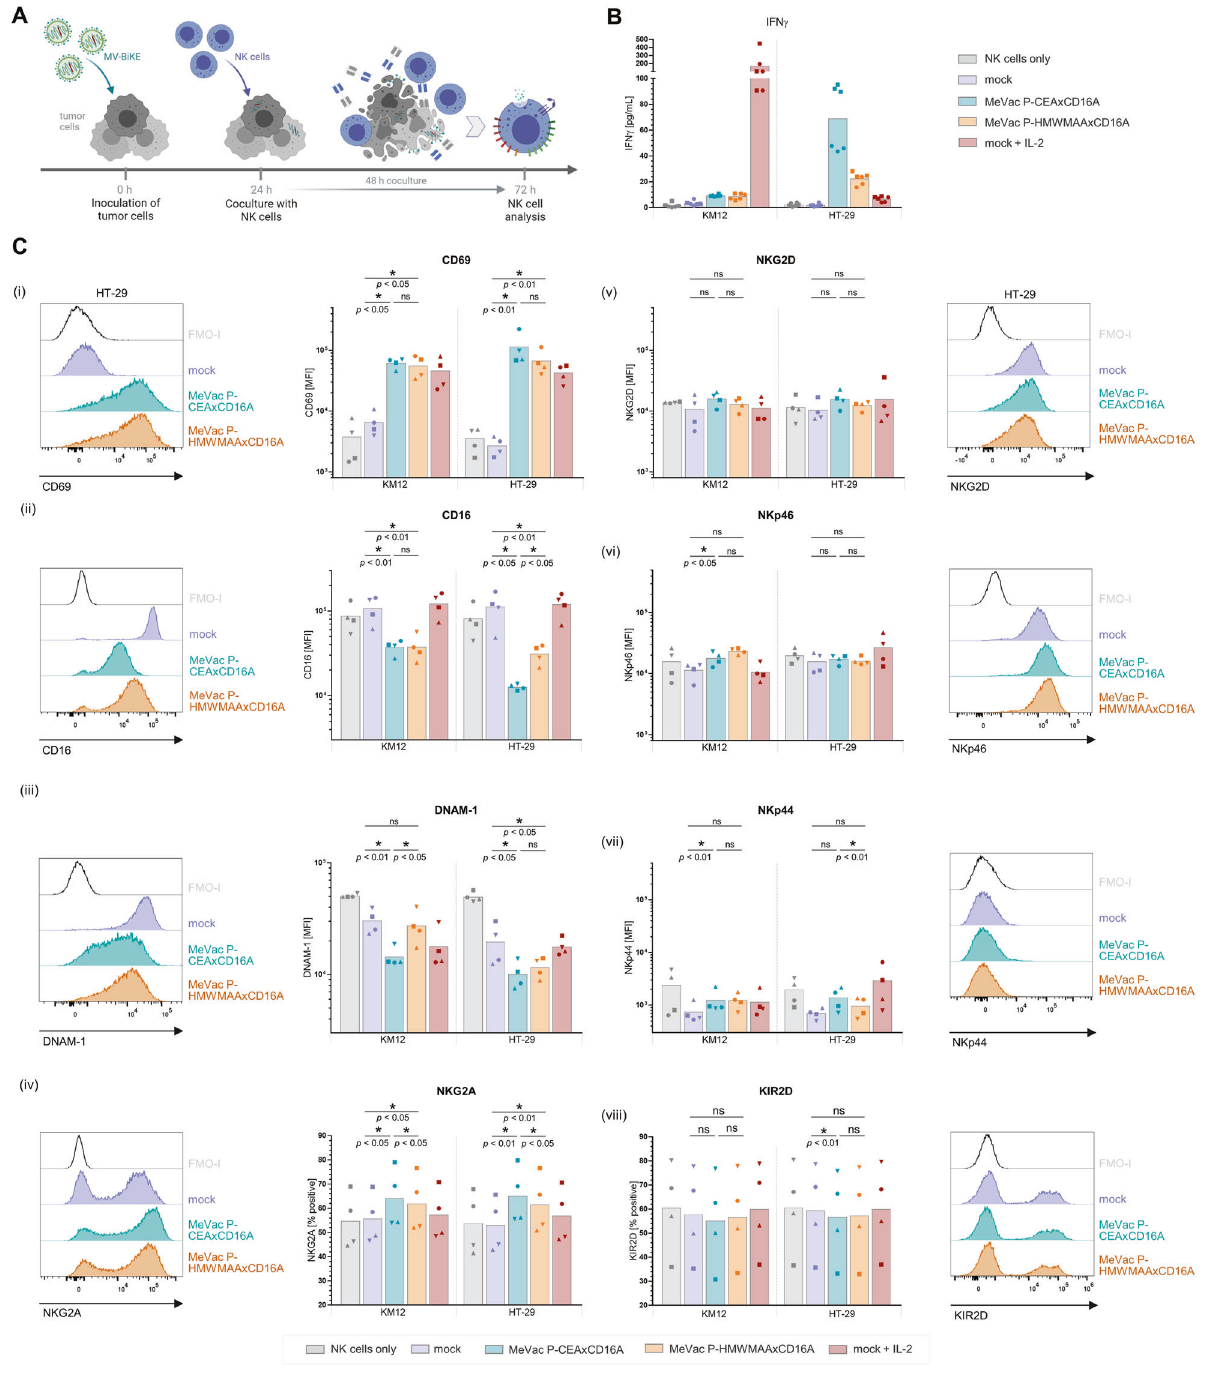
Fig. 4 NK cell characterization in response to MV or MV-BiKE therapy. NK cell surface markers and IFN γ release were analyzed after coculture with infected colorectal cancer cells. MV-BiKE infections were compared to NK cell only controls, mock or IL-2 stimulation. A Schematic outline of the experiment. B IFN γ concentrations in coculture supernatants were quanti fi ed by ELISA. Results are shown for KM12 and HT-29 tumor cells with technical triplicates for n = 2 donors, represented by different symbols. C Characterization of NK cell surface markers by fl ow cytometry. Exemplary histograms from one donor are depicted including Fluorescence Minus One + Isotype (FMO-I) controls for each marker. Mean fl uorescence intensity (MFI) or the percentage of cells expressing the respective marker are summarized for n = 4 donors. Different symbols represent individual donors. For CD16, the mean of three technical replicates is shown per donor. For additional data on MV alone or combined with puri fi ed vBiKEs, refer to Fig. S6. Statistical analysis was performed by one-way ANOVA with Š idák ’ s multiple comparisons